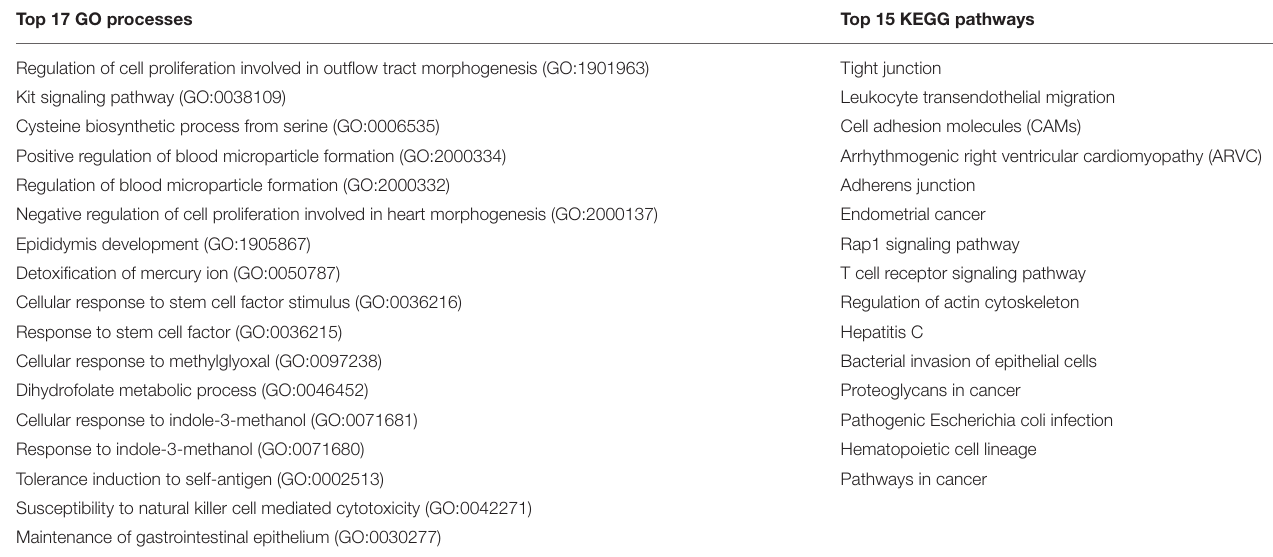
TABLE 8 | Top 17 GO processes and KEGG pathways related to the selected 210 gut-immune genes involved in absorption of essential nutrients. Top 17 GO